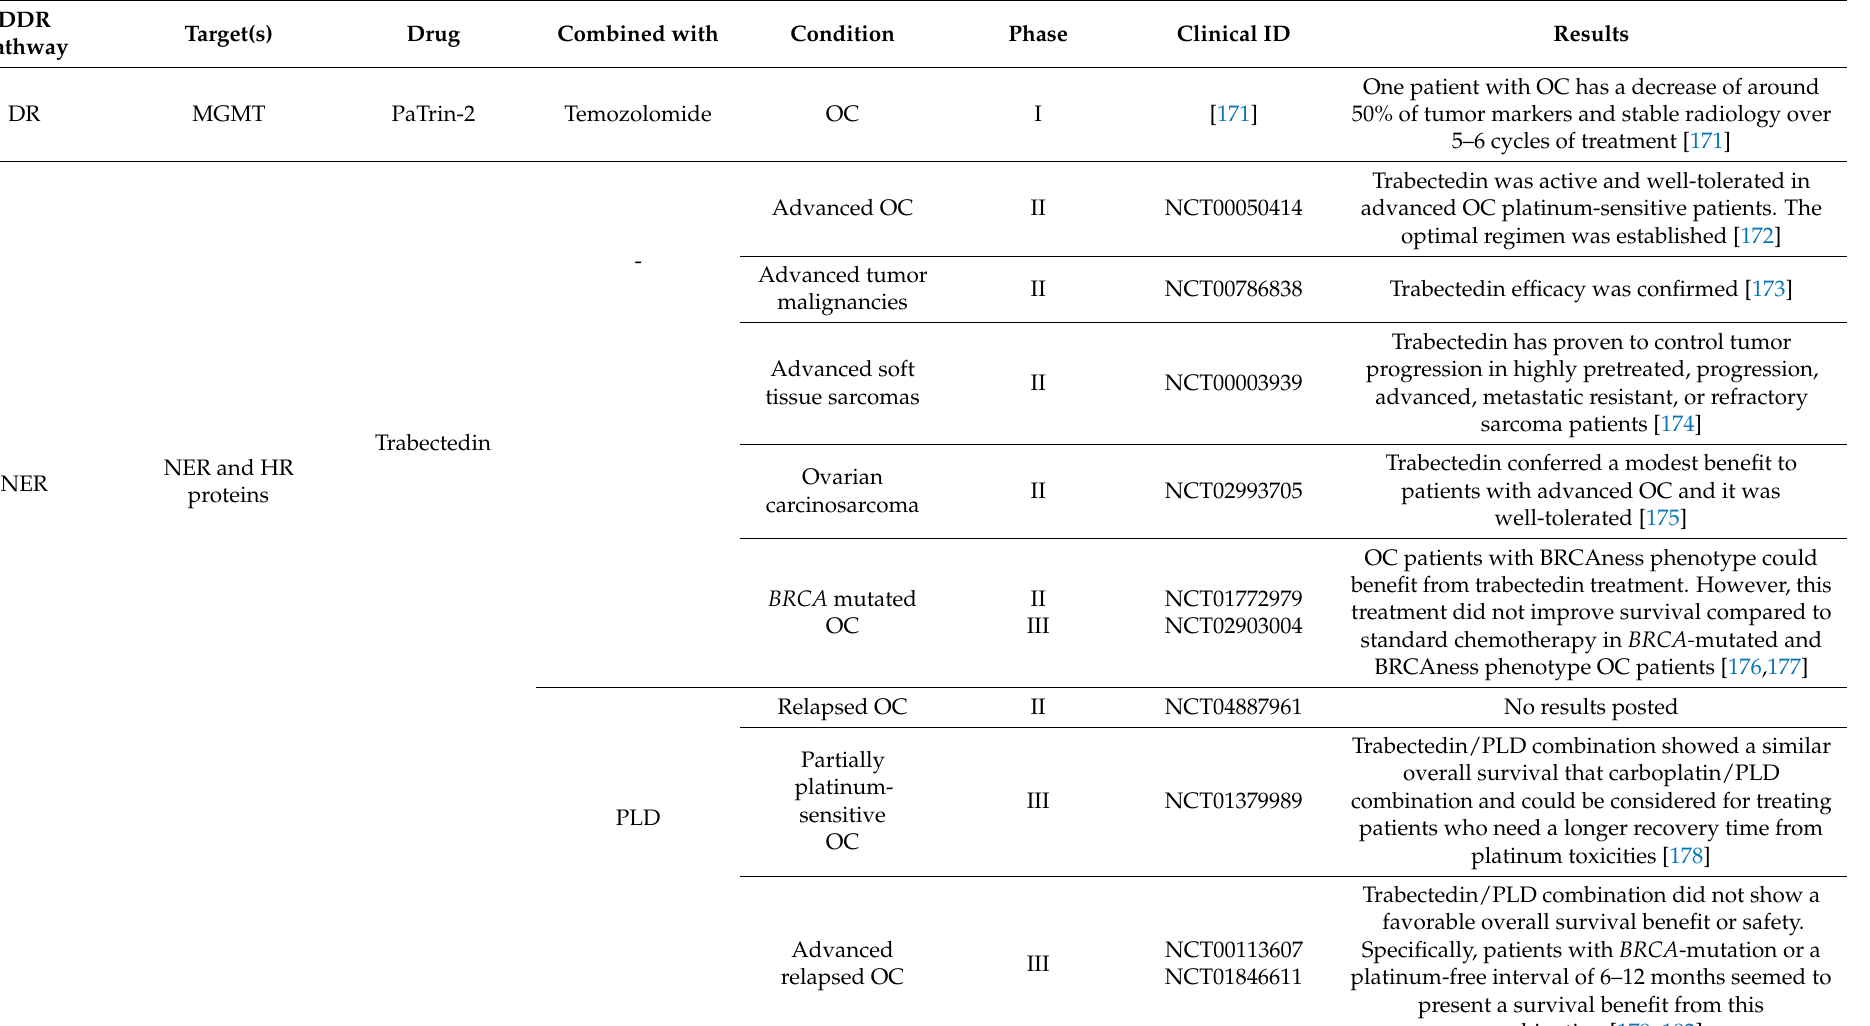
Table 5. DDR-targeting drugs investigated in clinical studies in monotherapy or in combination with other antitumor